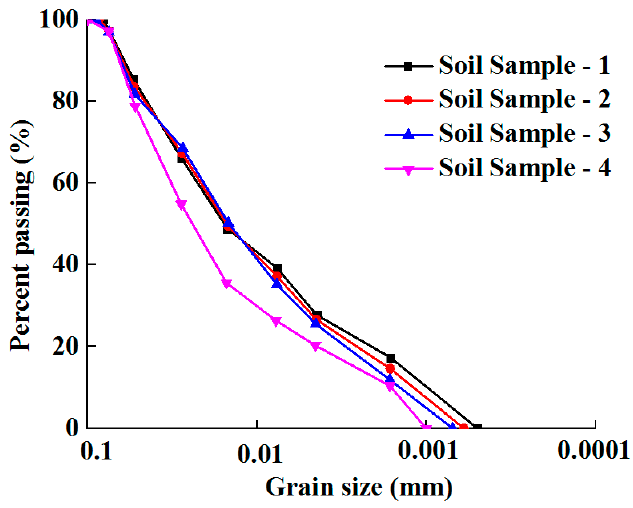
Figure 2. Grain-size distribution curves.